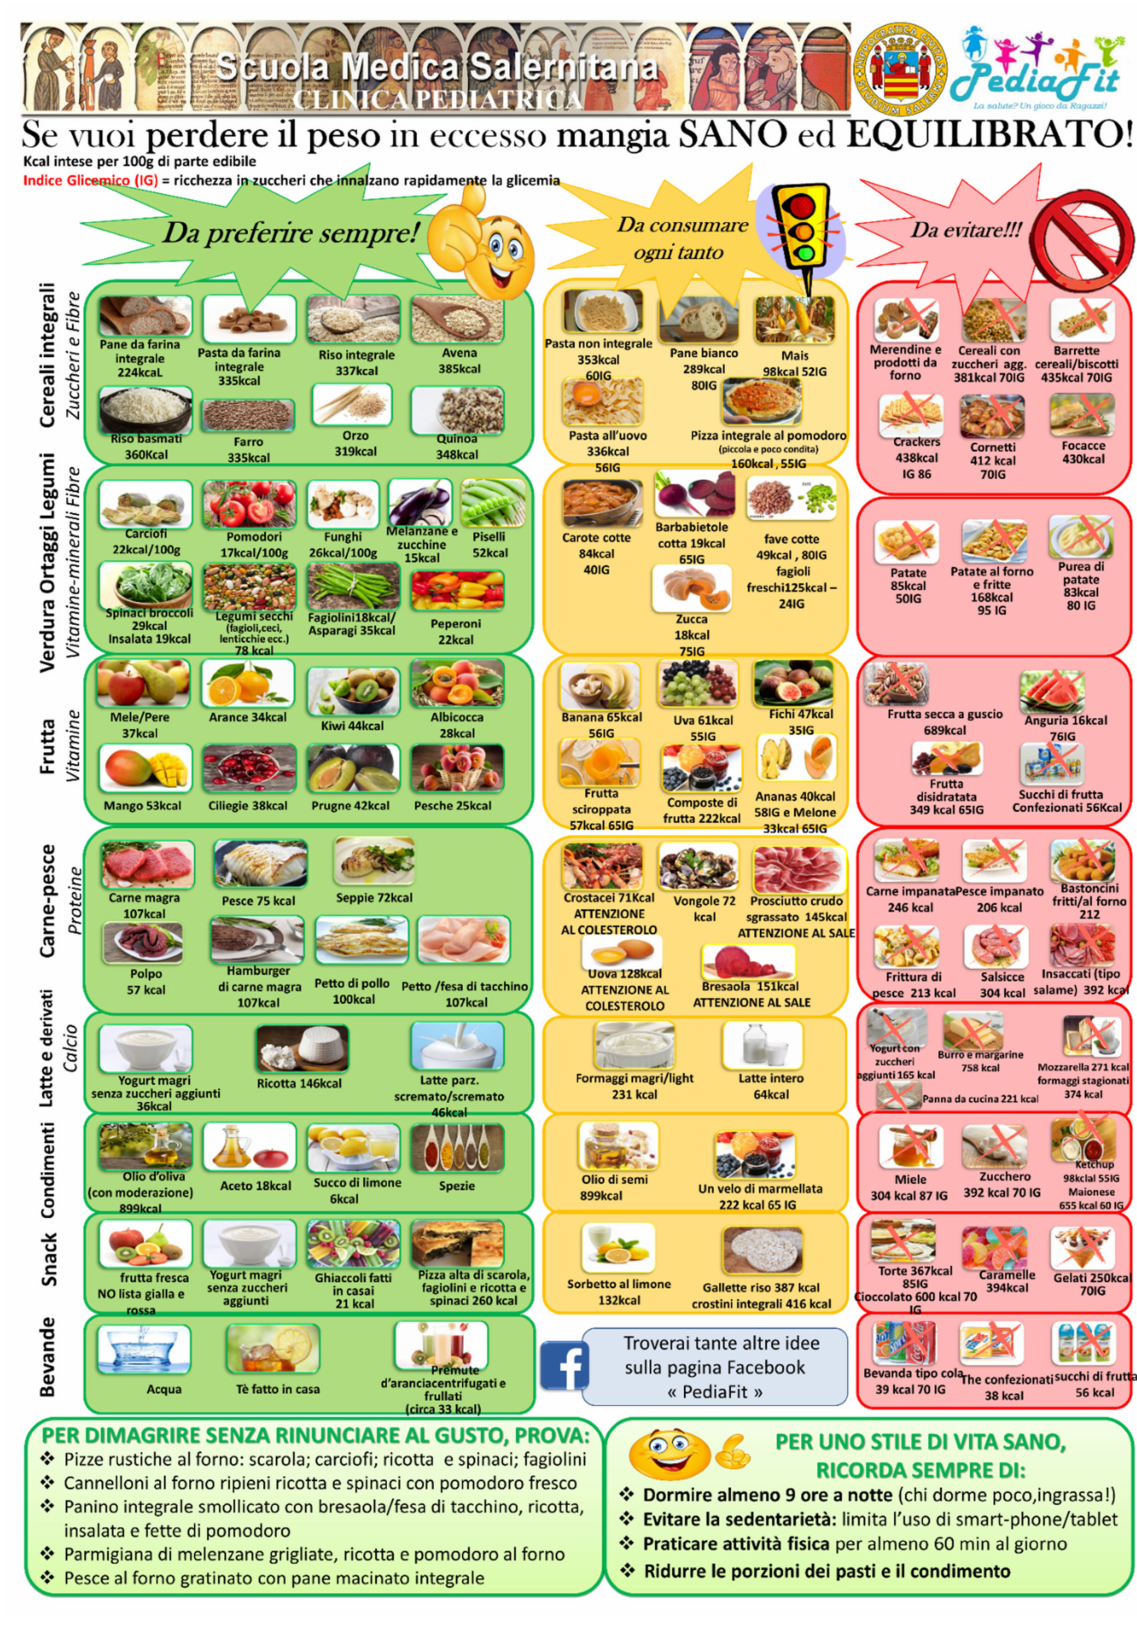
Figure A2. Original “Food traffic light” Italian